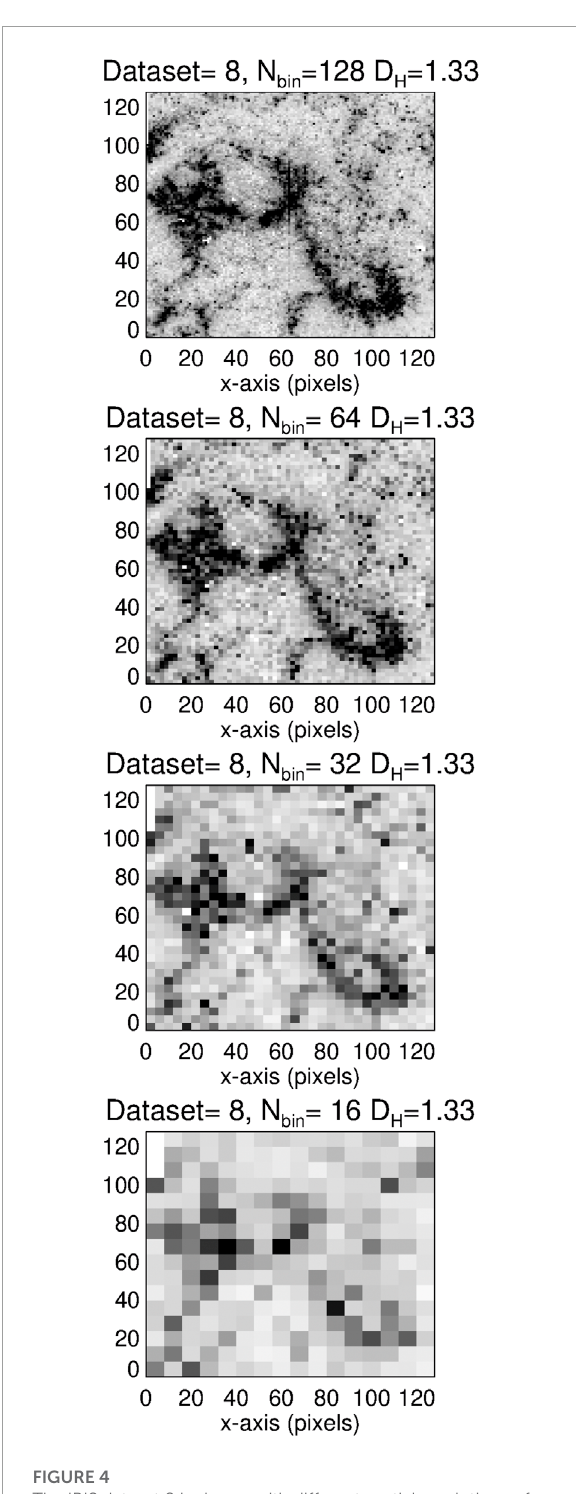
FIGURE 4 The IRIS dataset 8 is shown with different spatial resolutions of 128, 64, 32, and 16 bins, which demonstrates the scale-free definition of the Hausdorff dimension D H = 1 . 33. Black color indicates emission, and white color indicates the faint